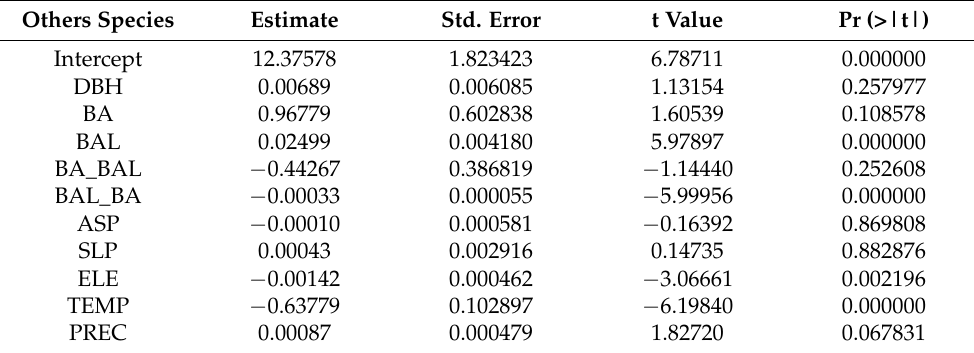
Table 4. Results of the linear mixed-effect model for others species diameter increment.